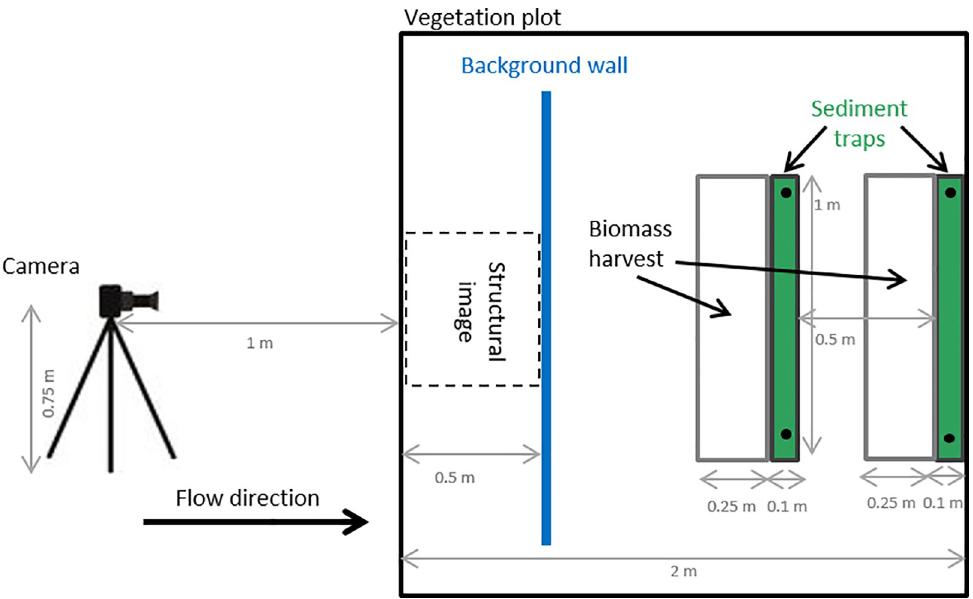
Fig 2. Set-up of different measurements in the vegetation plots (2m x 2m). The set-up of the green sediment traps (image in S2 Fig) and the defined area of biomass harvest upstream each plot after the flood event. It also shows the set-up for the structural images of the vegetation with the camera 1 m in front and the blue background wall 0.5 m inside the plot (image in S1 Fig).